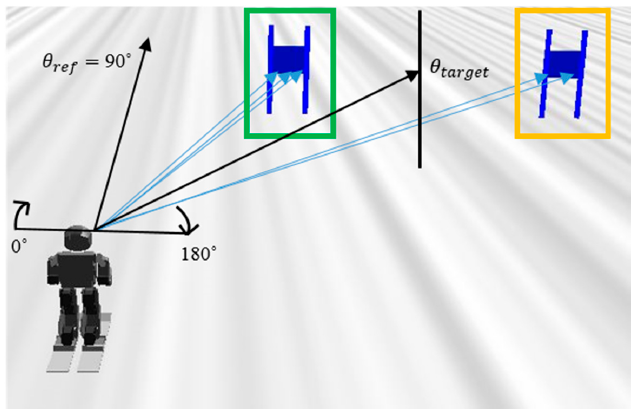
Figure 5. 𝜃 (cid:3045)(cid:3032)(cid:3033) is the direction of the skiing robot and 𝜃 (cid:3047)(cid:3028)(cid:3045)(cid:3034)(cid:3032)(cid:3047) is the angle from the skiing robot to the middle of the gate. middle of the